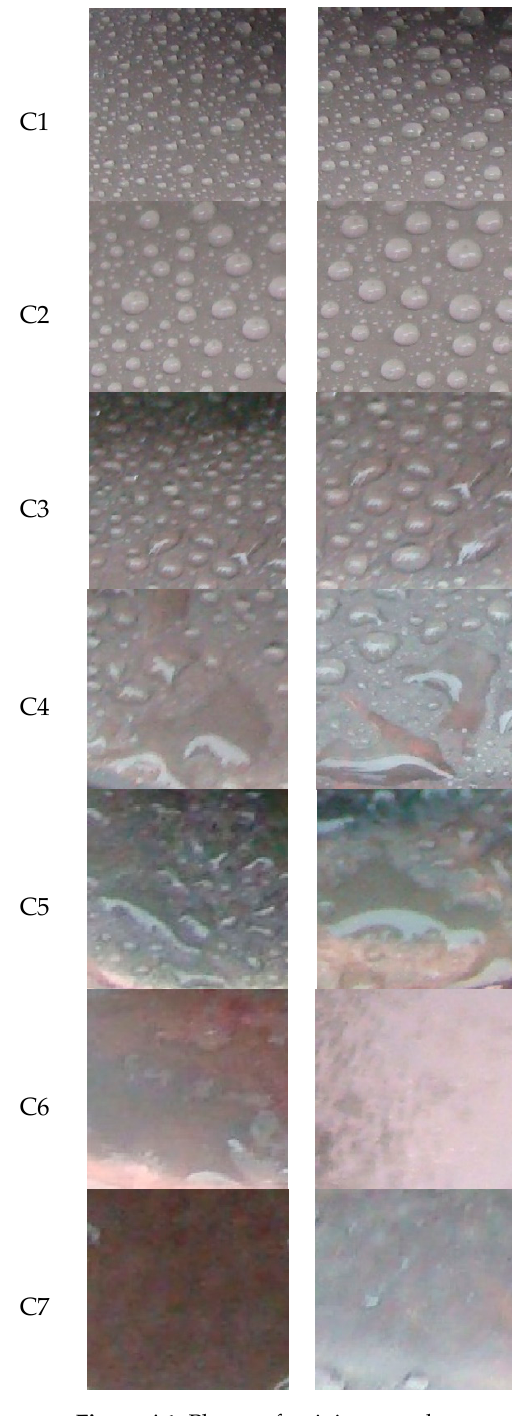
Figure A1. Photos of training samples.